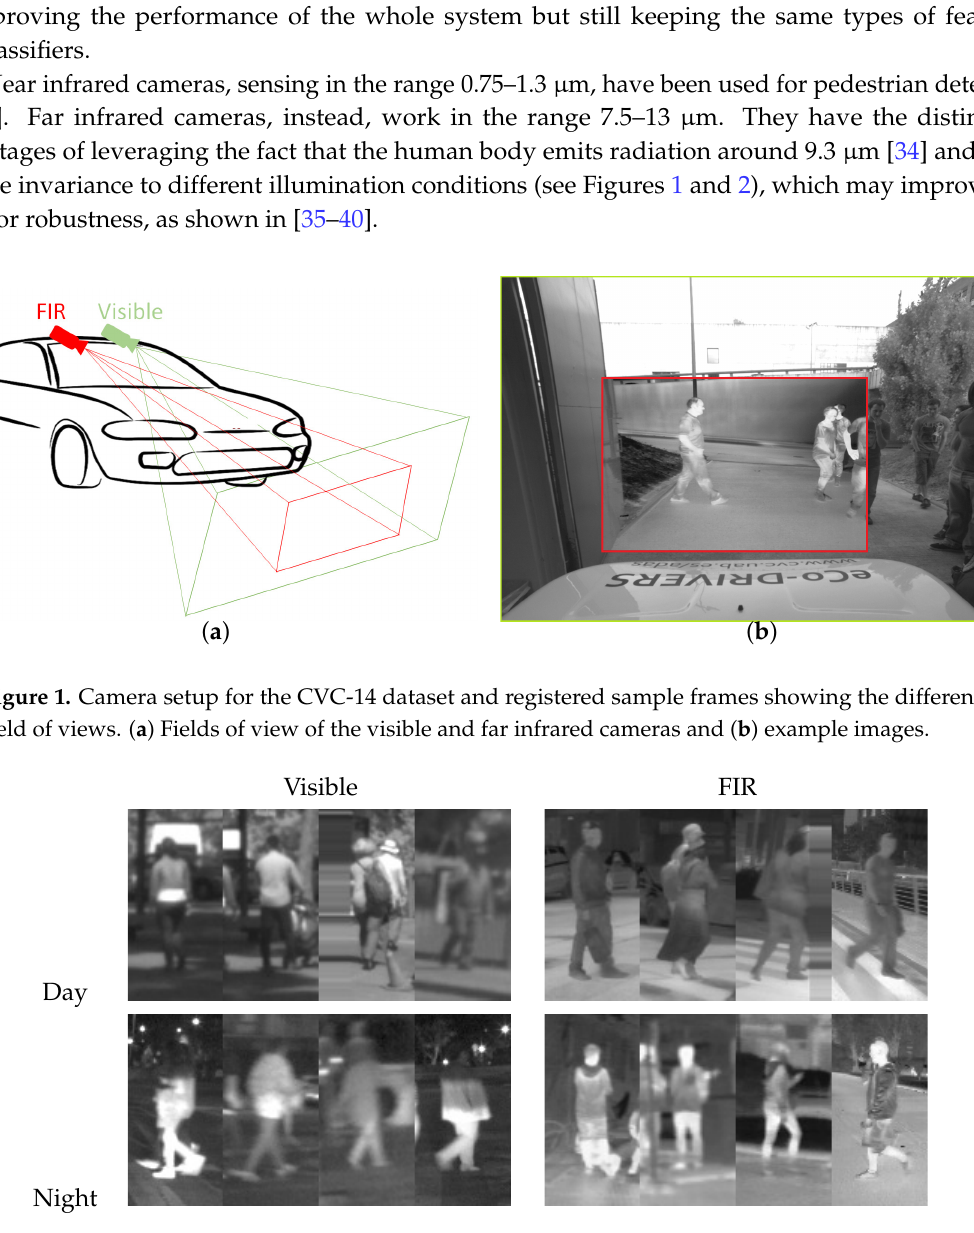
Figure 2. Sample pedestrians from the CVC-14